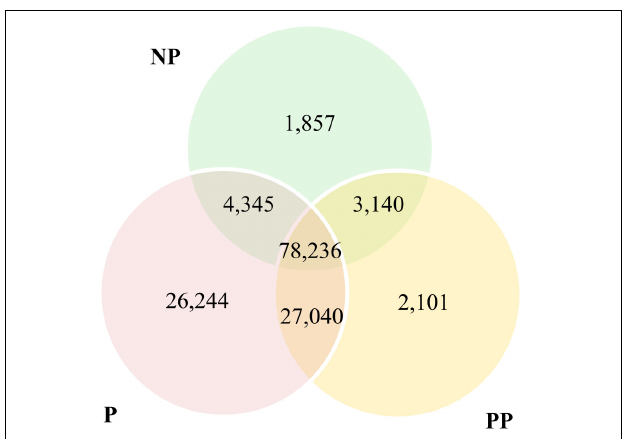
FIGURE 3 | Venn diagram of transcripts of the de novo assembly of Diatraea saccharalis larvae expressed in control (NP) and parasitized (P) and pseudoparasitized (PP) larvae by Cotesia flavipes.